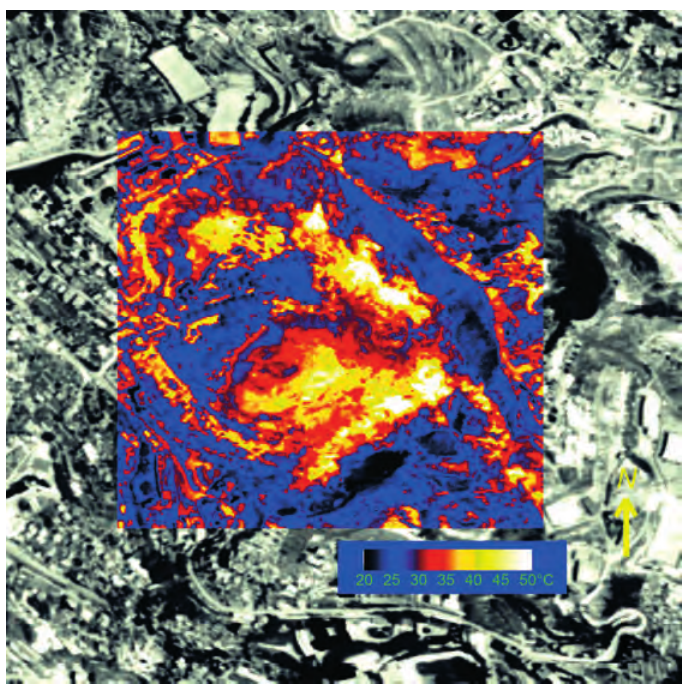
Fig. 5. Surface temperature map of the Solfatara crater retrieved by DAIS data. Table II. Comparison between ground measured temperature and image retrieved temperature at the sites shown in fig. 1.